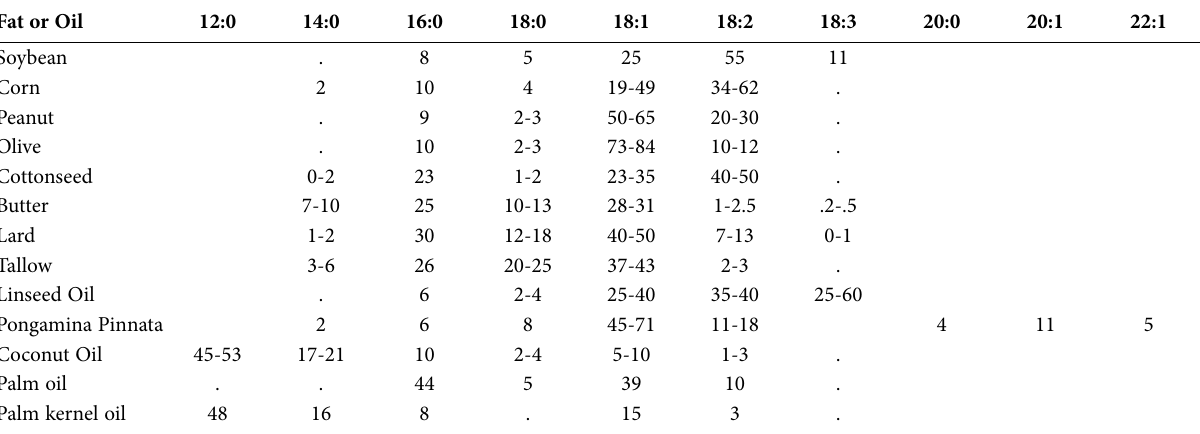
Table 1. Fatty acid composition of common oils and fats. Fat or